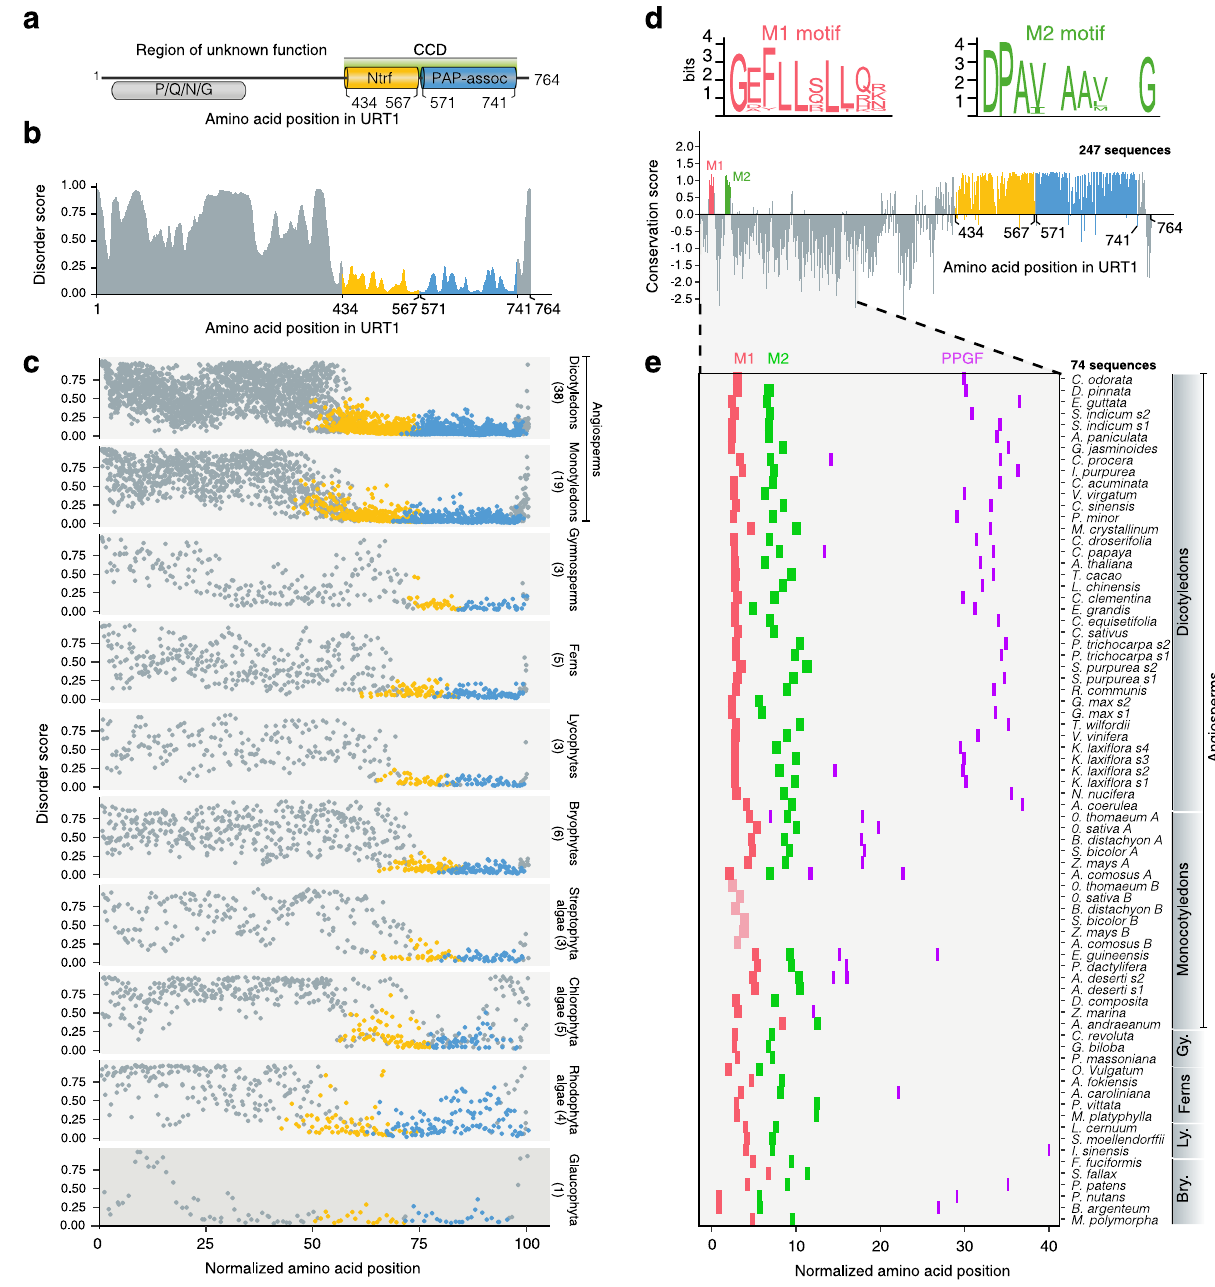
Fig. 1 Short linear motifs are conserved in plant URT1 orthologs. a Domain organization of URT1. CCD catalytic core domain, Ntrf polymerase β -like nucleotidyltransferase domain, PAP-assoc Poly(A) polymerase-associated domain. The region of P/Q/N/G enrichment is indicated. Numbers refer to amino acid positions in URT1. b Disorder propensity of URT1 predicted by ESpritz-NMR 74 and aggregated by FELLS 75 . c Disorder propensity of URT1 orthologs in Archaeplastida. The length of URT1 sequences was normalized to 100. The number of sequences considered are indicated for each group. d Sequence conservation of URT1 orthologs among land plants. The conservation score was calculated with ConSurf 76 from an alignment of 247 sequence homologs of URT1 in land plants (see Supplementary Data 1) and using URT1 sequence as a reference. Consensus logos for M1 and M2 motifs are displayed in bits and were calculated from the alignment. e Occurrence of M1 (red), M2 (green), and PPGF (purple) motifs among URT1 orthologs of land plants. The slightly divergent M1 motif of URT1B in Poales is in light red. The length of 74 URT1 sequences was normalized to 100. The source data are available in Supplementary Data